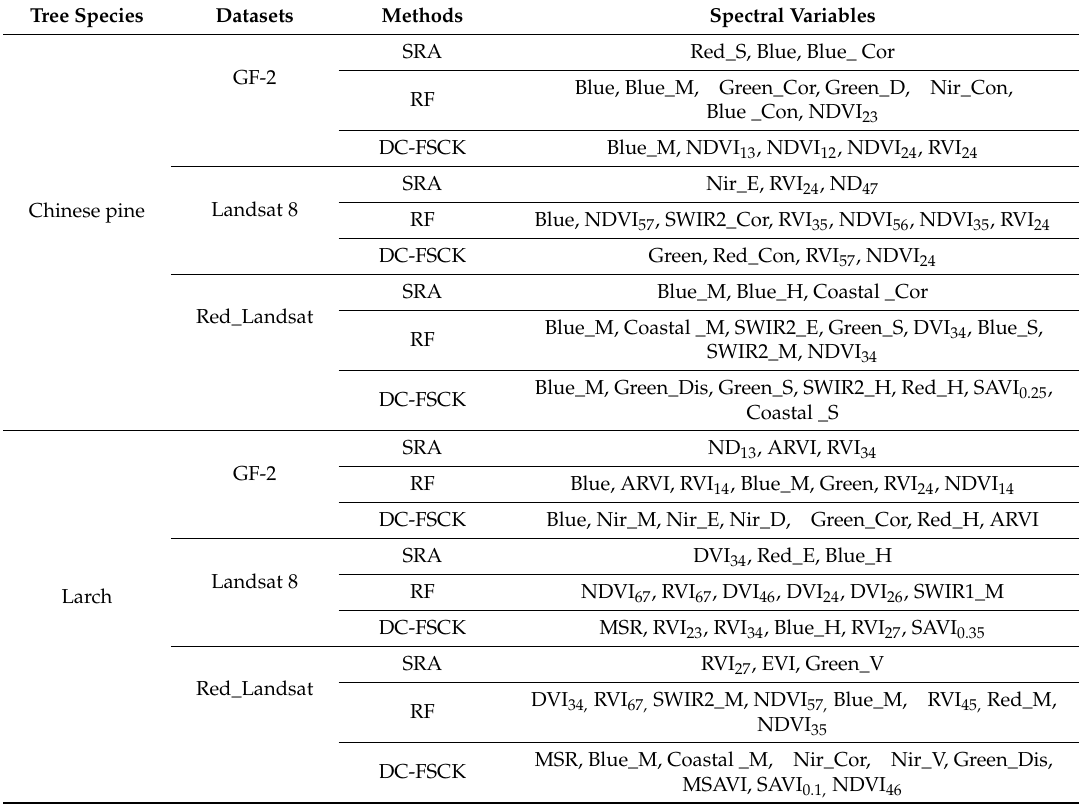
Table 5. Spectral variables selected by di ff erent methods for forest GSV estimation (Note: M—mean, V—variance, H—homogeneity, Con—contrast, D—dissimilarity, E—entropy, S—second moment,